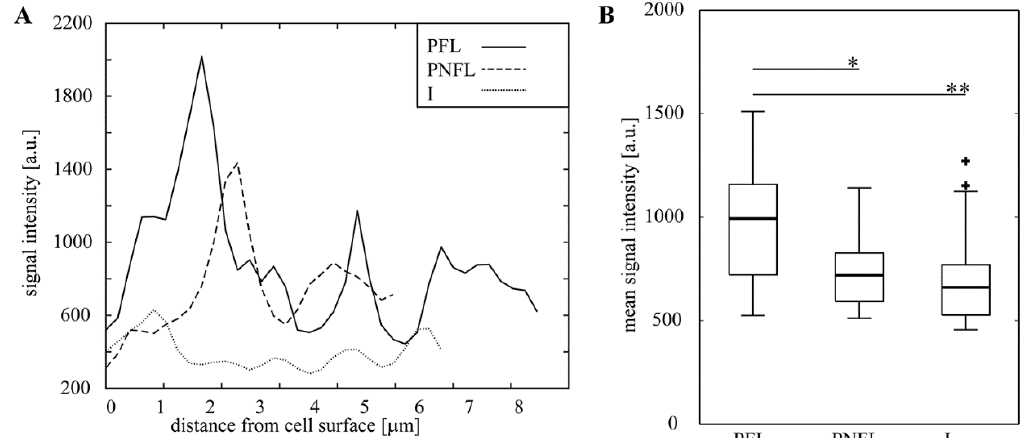
Figure 7. Calcofluor signal intensity in cell walls of lemma fibres. A. Signal intensity measured along transects marked in Figure 6. B. Mean signal intensities for cell walls of differently treated lemmas. Thick lines within boxes represent medians; boxes delimit the first and third quantiles; whiskers extend from each end of the box to the adjacent values in the data as long as the most extreme values are within 1.5 times the interquartile range from the ends of the box; crosses represent outliers. In each sample, walls of 18 cells from different portions of 2 lemmas were analyzed. Statistical significance is presented as: * p < 0.05; ** p <0 .01.